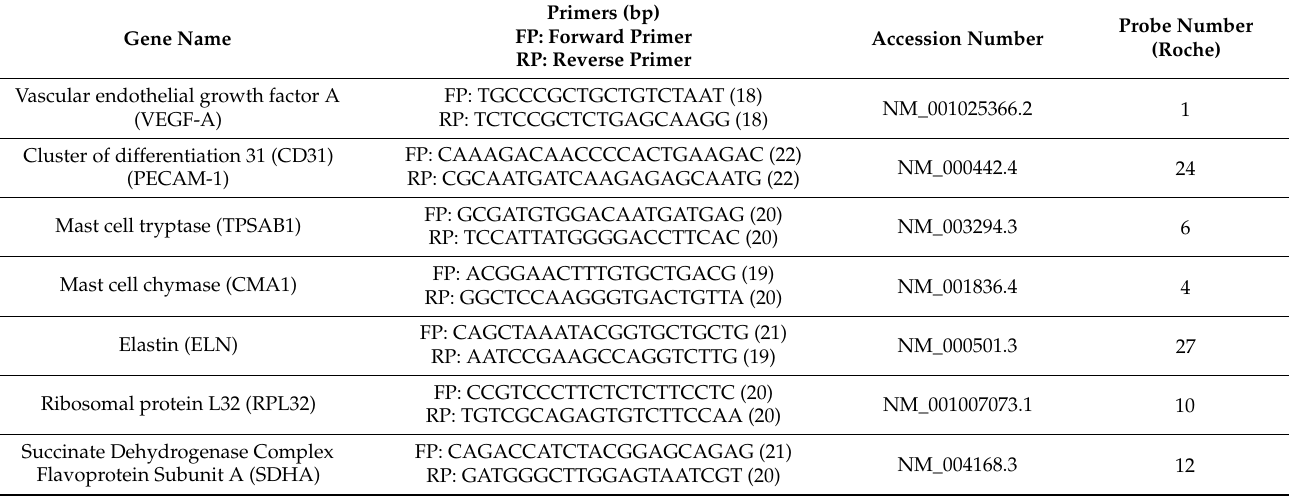
Table 5. Details of primers and probes used for